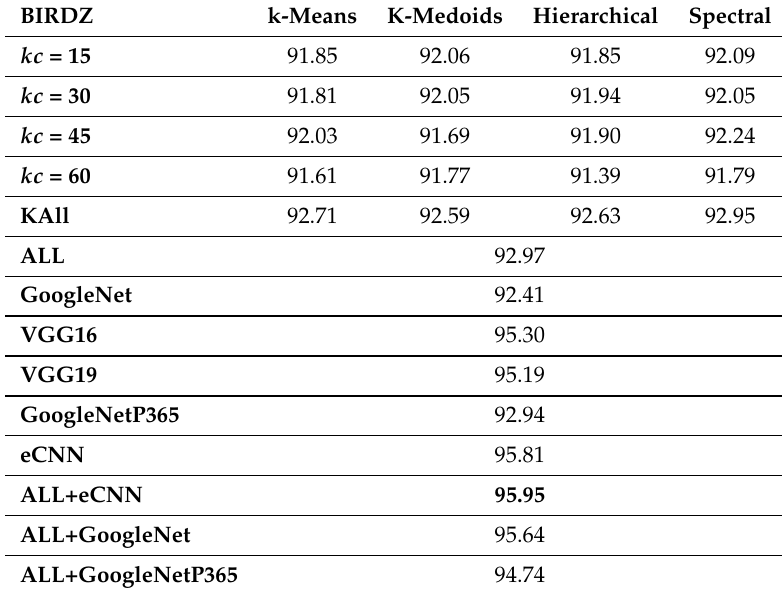
Table 2. Classification accuracy on the BIRDZ